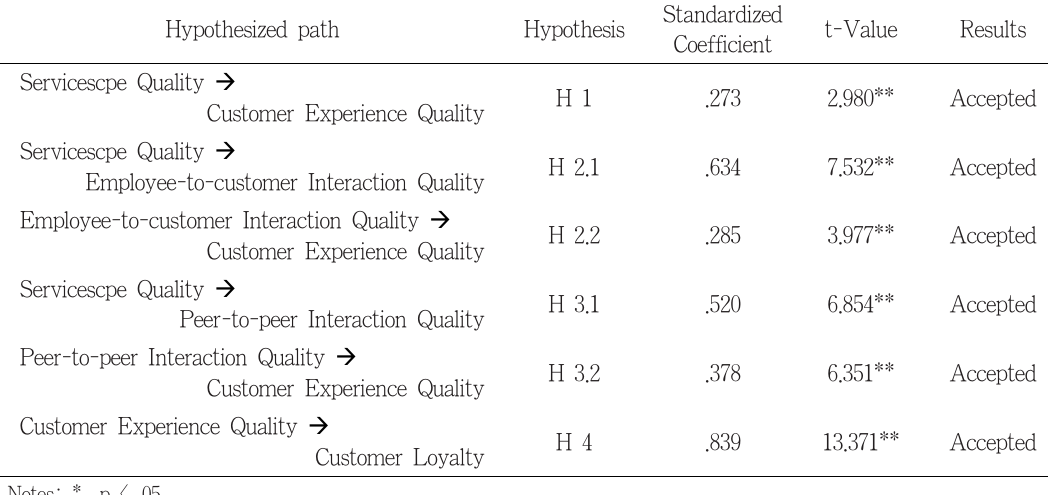
<Table 4> Structural equation model results: path